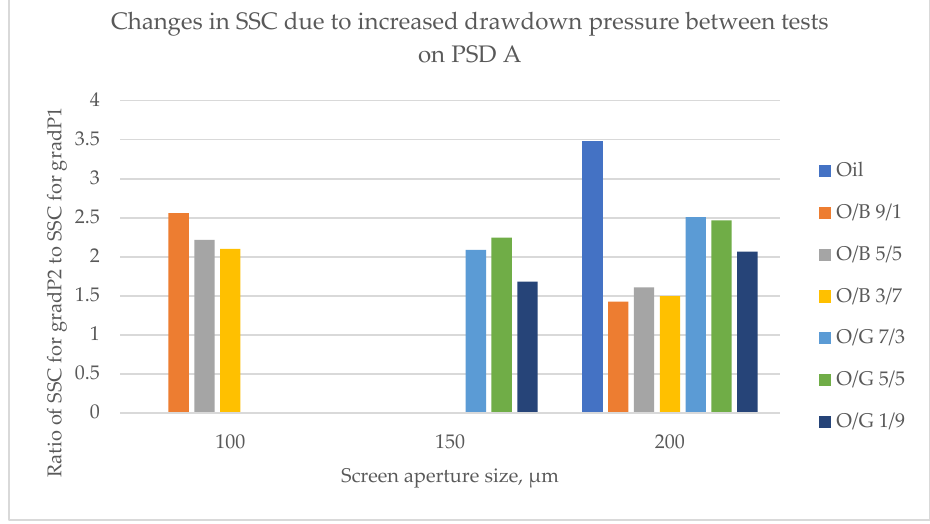
Figure 11. Relative change in suspended solids concentration due to increased drawdown pressure between the tests.